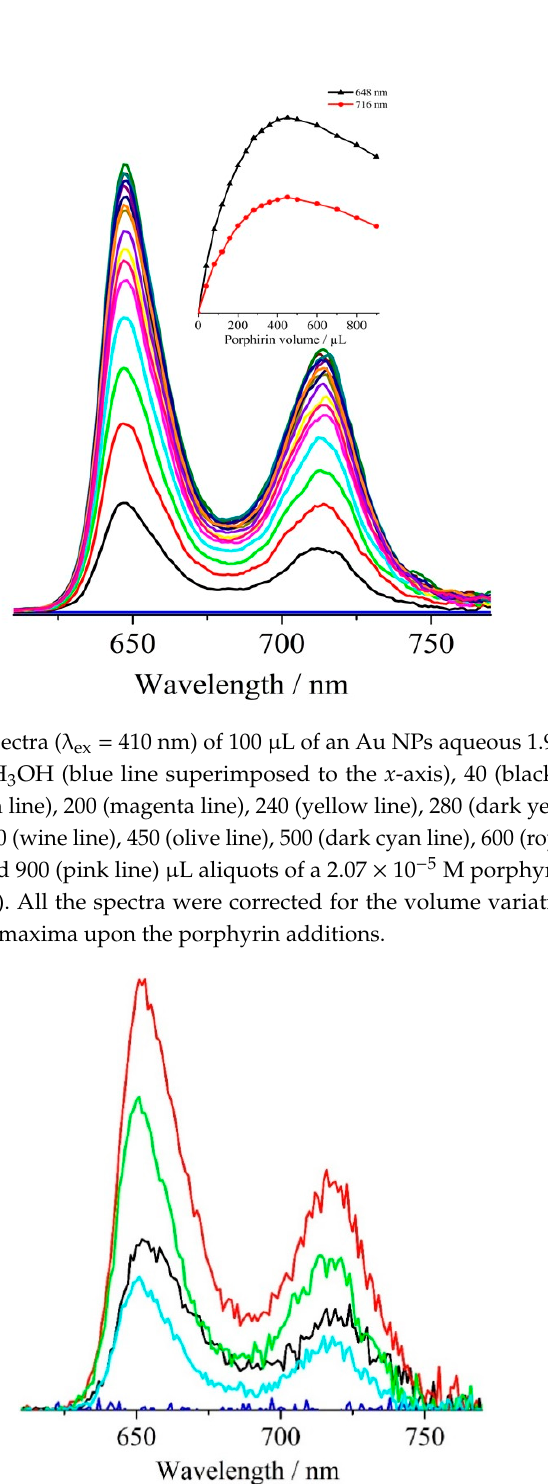
Figure 10. Fluorescence spectra ( λ ex = 410 nm) of the Au NPs–porphyrin systems centrifuged and deposited on quartz substrates. Starting Au NPs (blue line), centrifuged solutions upon the addition of 240 (black line), 450 (red line), 700 (green line), and 900 (cyan line) µL aliquots of a 2.07 × 10 − 5 M porphyrin CH 3 OH solution (final total volume of the solution 3 mL).